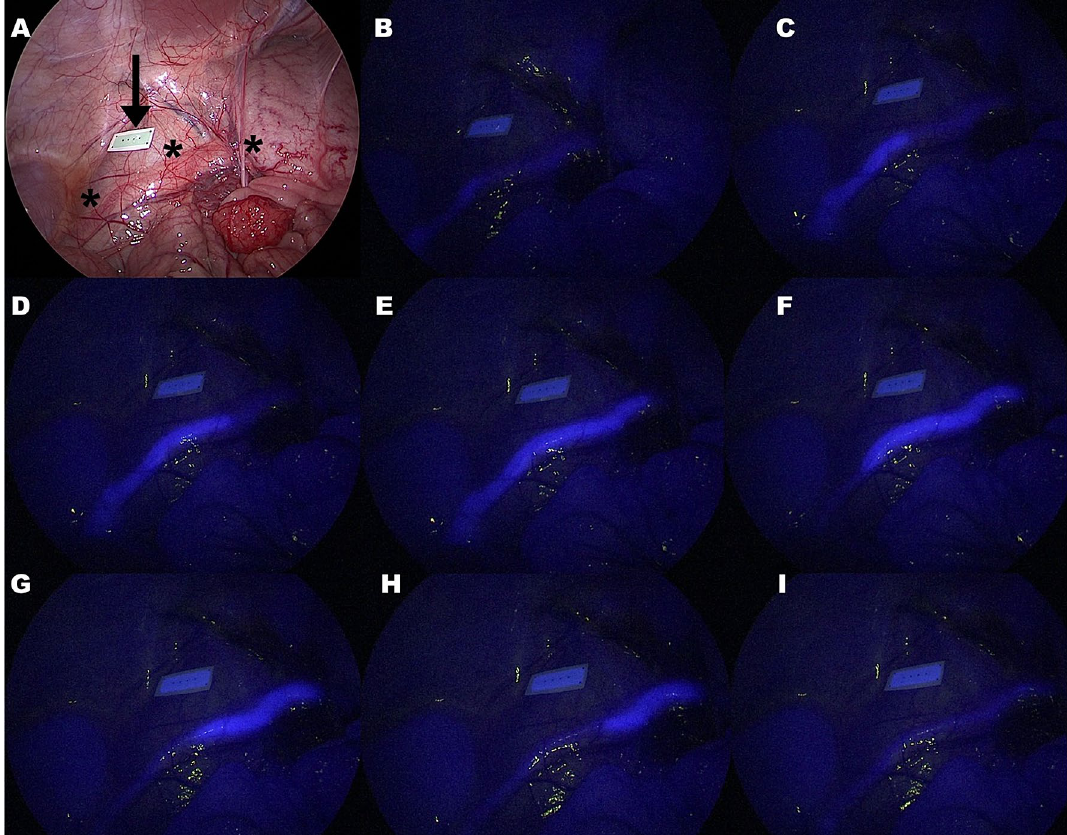
Figure 3. In ( A ), demonstration of the IRDye 800BK under white light. The stars indicate the ureter and the arrow the calibration reference card. In a near-infrared mode ( B – I ), the ureter is not clearly visible before ( B ) and after ( I ) a ureteral peristaltic wave ( C – H ) progresses. The duration of the peristaltic wave is variable, making the fluorescence-aided ureter visualization also variable. In this picture the time between photogram ( C ) and ( H ) was approximately of 50 s, whereas photogram ( E ), the only one showing the ureter entirely, was visible for 3 s, given the progression of the peristaltic wave. For this reason, using the dye the ureter was entirely visible only for 3 s, in this example. Additionally, the high background fluorescence given by the surrounding structures, which de facto limits clear ureter delineation, in absence of the peristaltic wave ( B and I ) is also visible.